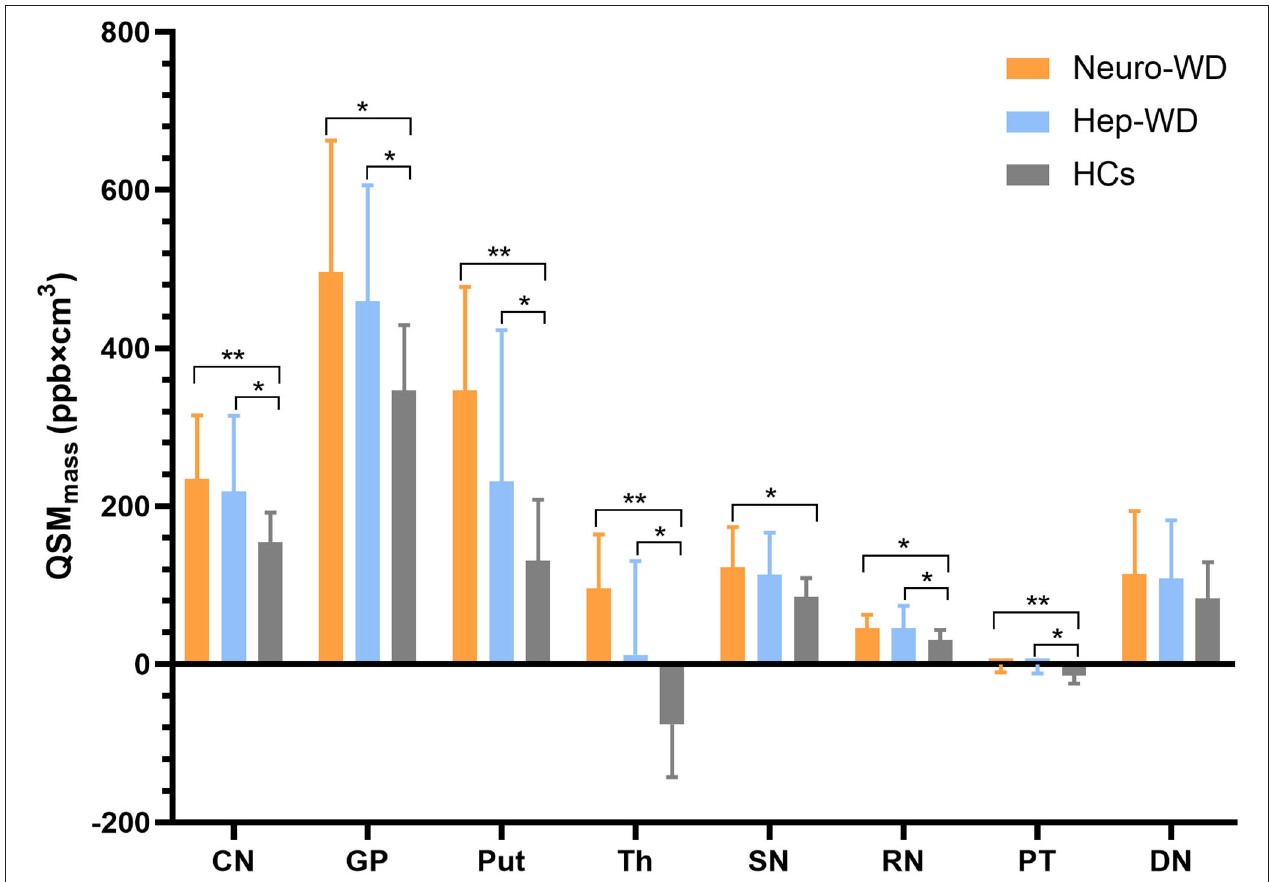
FIGURE 5 | Comparison of total susceptibility values between different groups. Comparison between healthy control (HCs) and patients with WD: * p < 0.017 and ** p < 0.001. Patients with neuro-WD and patients with hep-WD had similar total susceptibility in all examined deep gray matter nuclei. Error bars indicate standard deviation. CN, head of the caudate nucleus; DN, dentate nucleus; GP, globus pallidus; Put, putamen; RN, red nucleus; SN, substantia nigra; Th, thalamus; PT, pontine tegmentum.